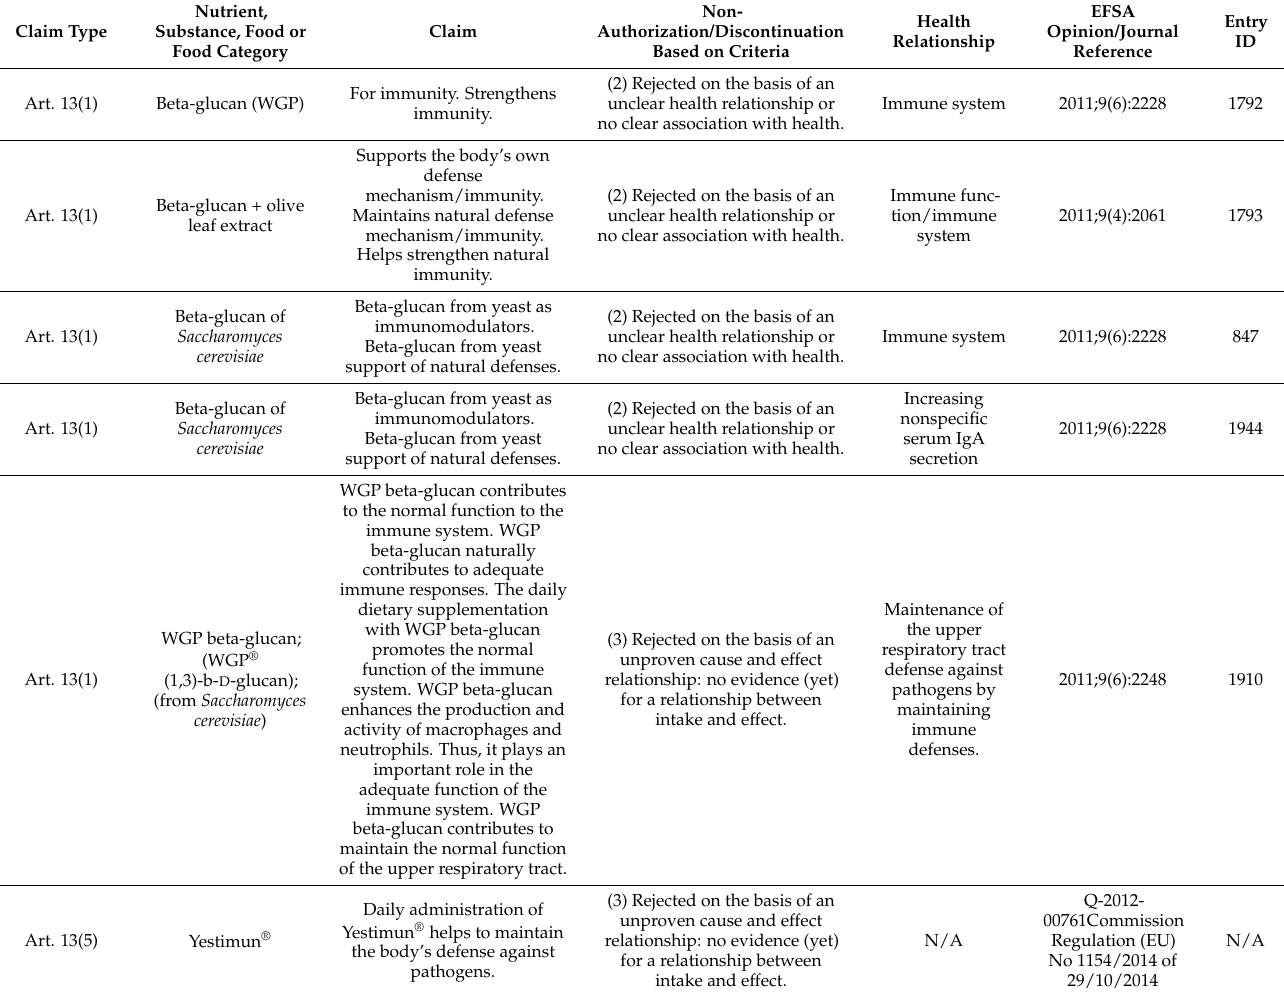
Table 2. Claims regarding fungal beta-glucan applications related to the immune